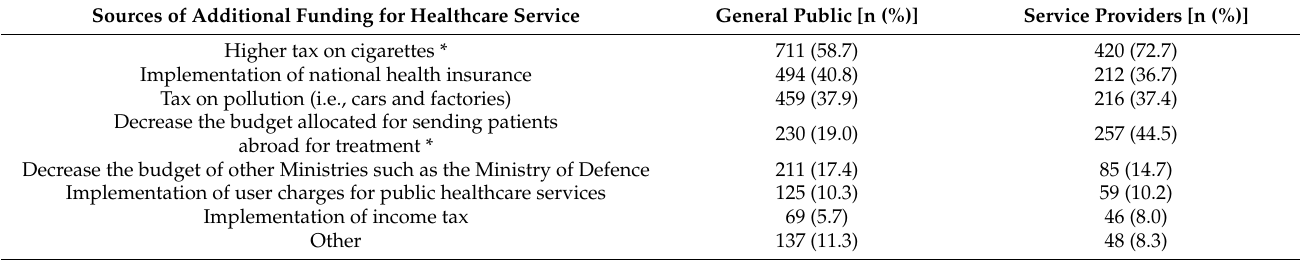
Table 6. Preferred sources of additional funding for healthcare services in Kuwait.